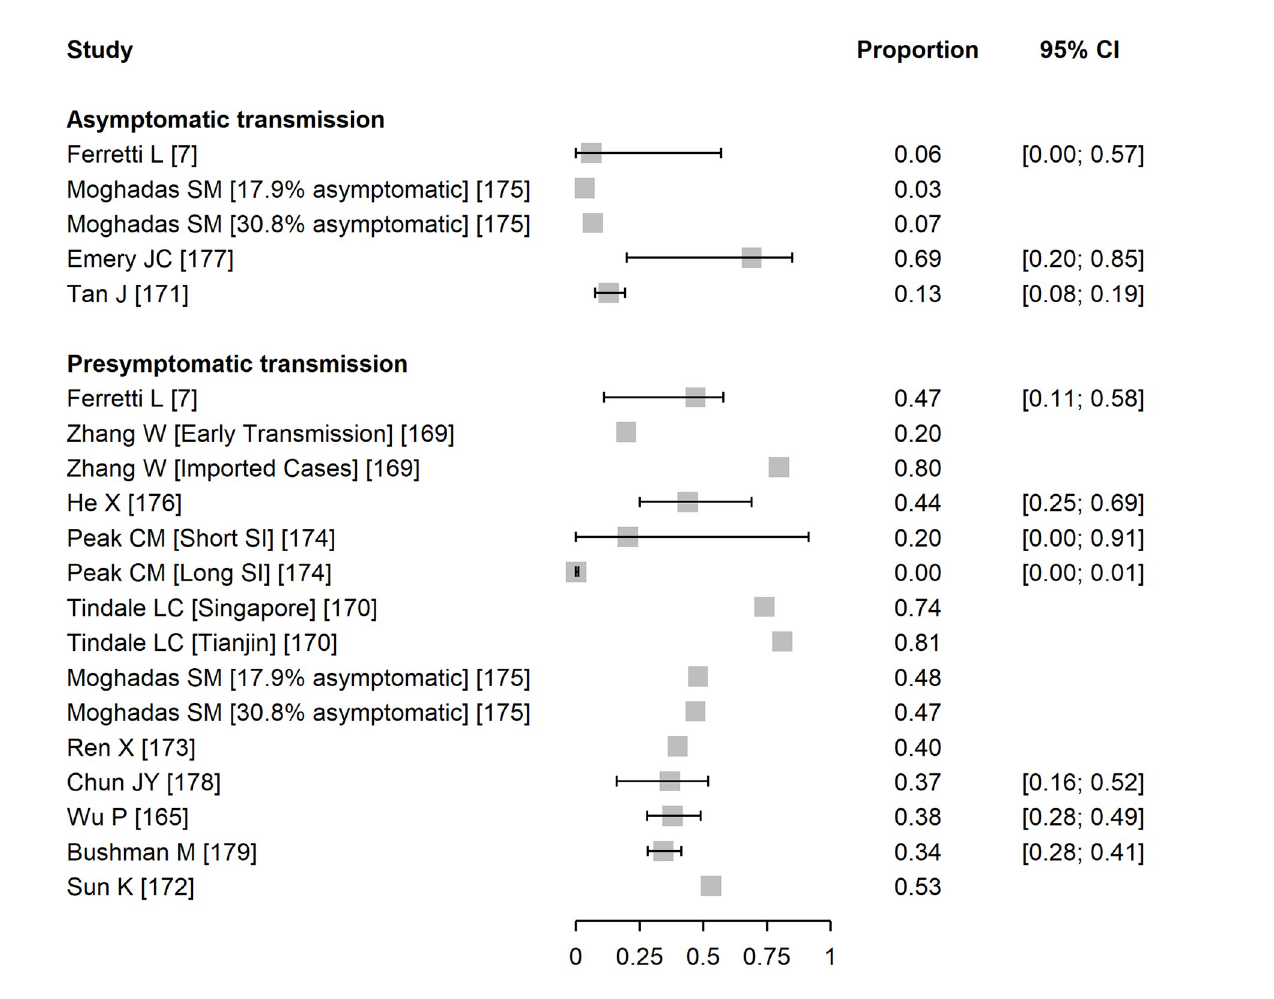
Fig 3. Forest plot of proportion of SARS-CoV-2 infection resulting from asymptomatic or presymptomatic transmission. For studies that report outcomes in multiple settings, these are annotated in brackets. CI, confidence interval; SI, serial interval; SARS-CoV-2, Severe Acute Respiratory Syndrome Coronavirus